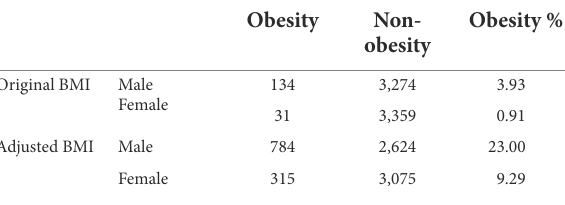
TABLE 7 Comparisons between original and adjusted BMI cutoffs in obesity screening.